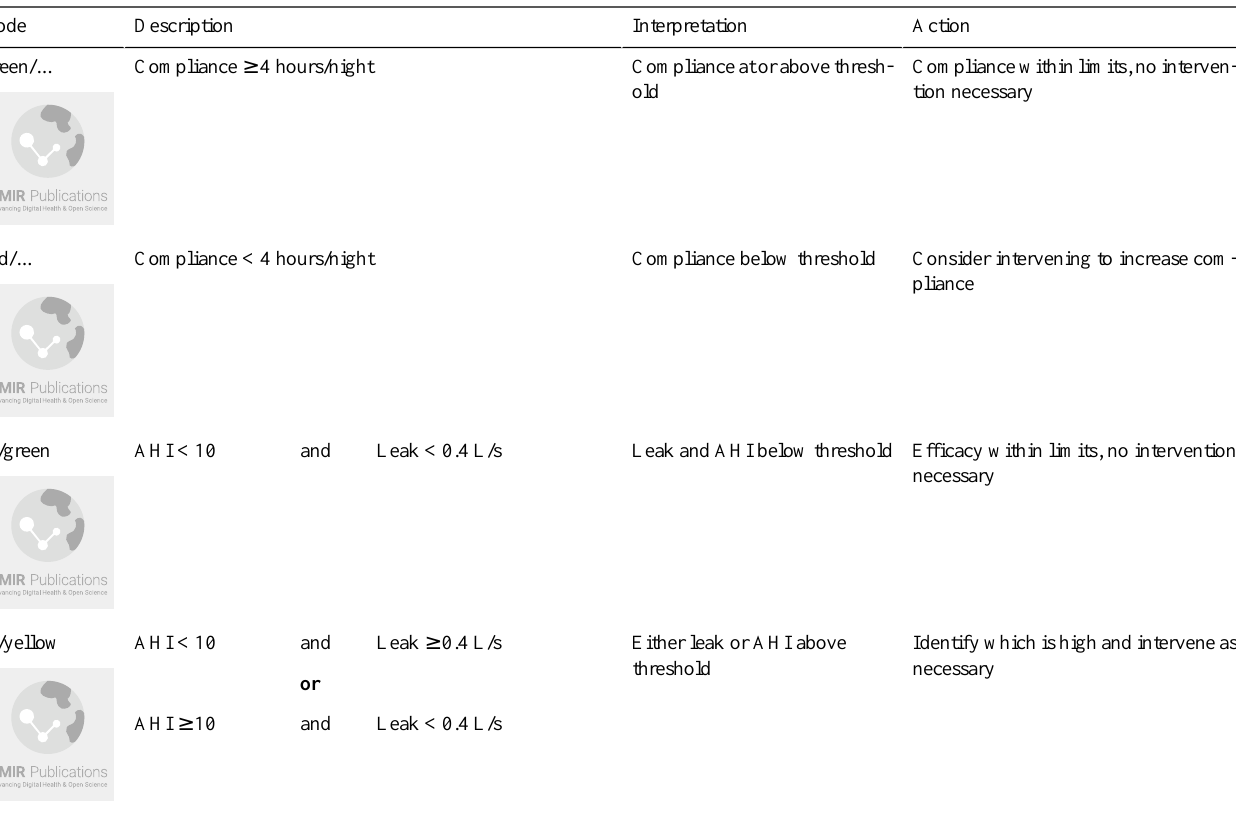
Table 2. Color-coding scheme summarizing compliance and efficacy measures on the ResTraxx Data Center